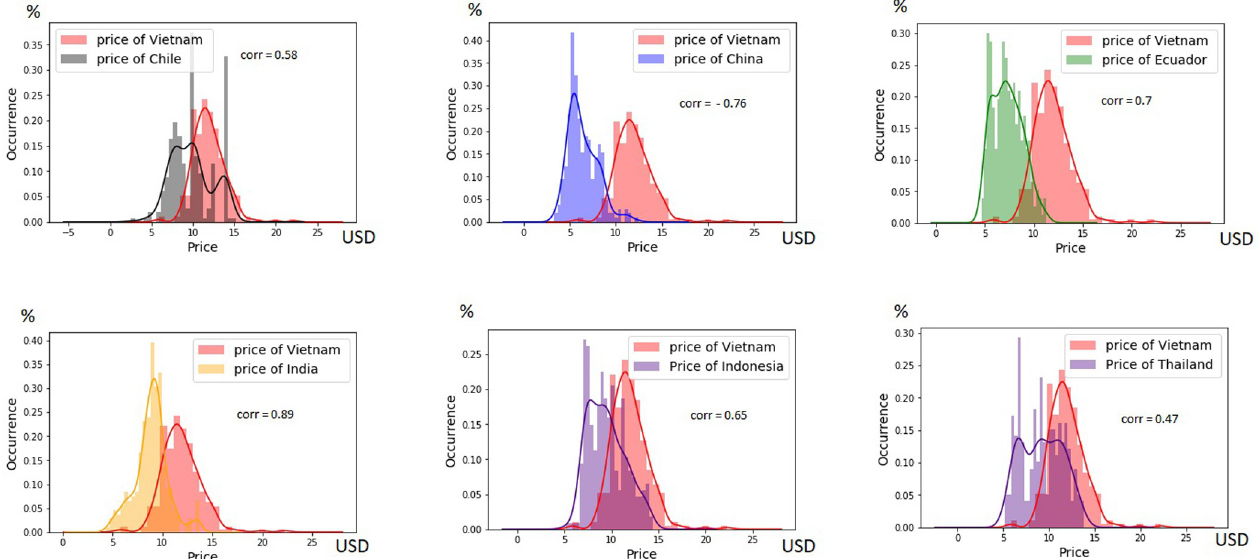
Fig 1. The correlations price between Vietnamese export shrimp and that of other countries.